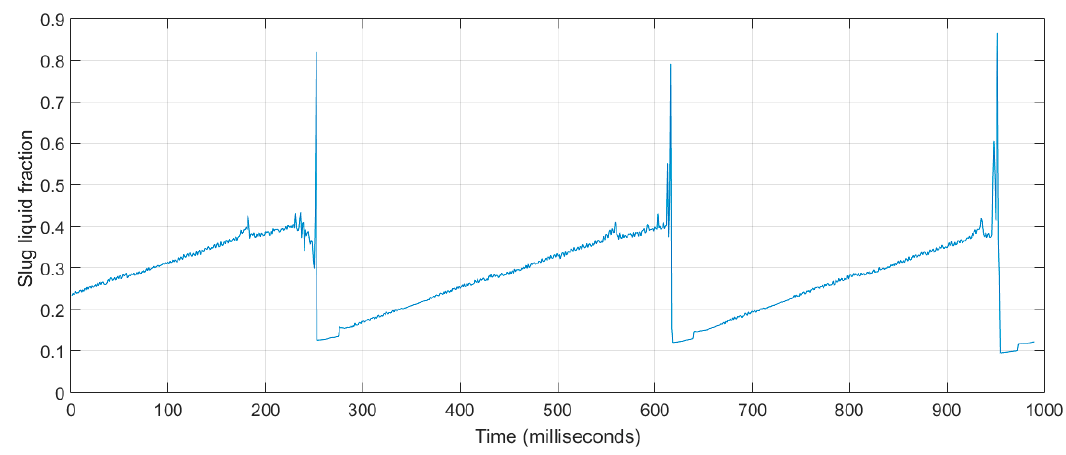
Figure 18. Liquid fraction distribution in slug flow.